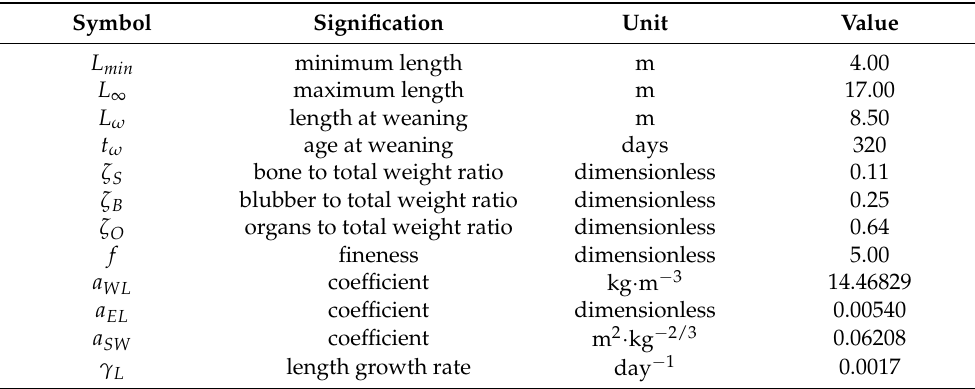
14—Arabian Sea. Five parallels structure the space: the equator, the tropical latitudes and the summer limits of the Ice Packs in the Arctic (75 ◦ N) and Antarctic (72 ◦ S). Table 4. Table of the parameters used for numerical